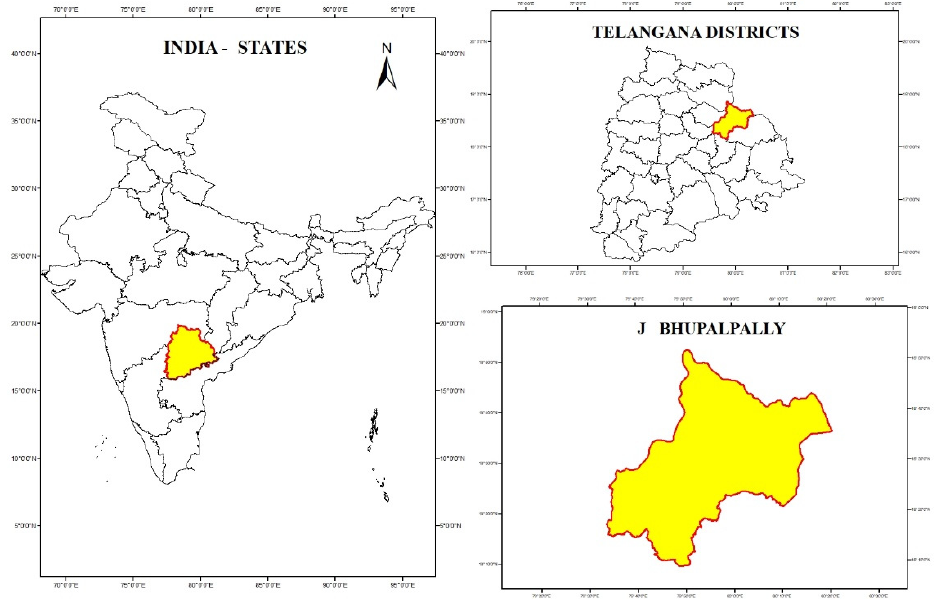
Figure 1. Study Area for Pigeon Pea crop identification, J Bhupalpally District, Telangana state, In- dia.